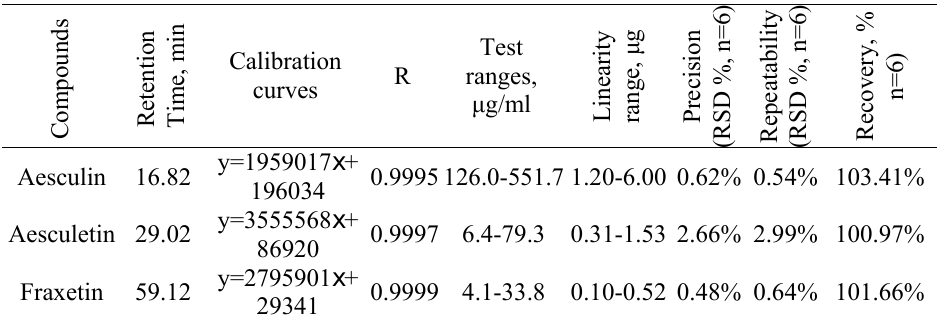
Figure. 1. HPLC chromatogram at optimized conditions (the peaks marked with a-c were aesculin, aesculetin and fraxetin) Table 1 . The methodology parameters and the calibration curve of the reference